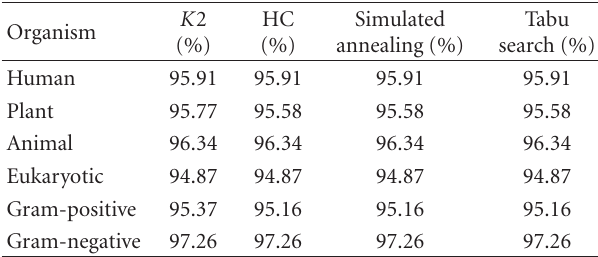
Table 6: The accuracy of some Bayesian network classifiers in weka by first